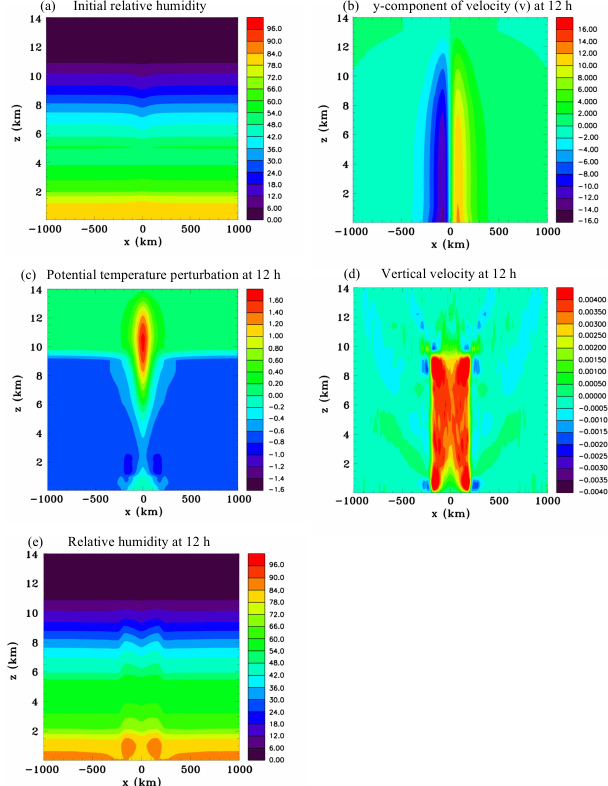
Figure 10. Vertical sections for Experiment 8: the forced core case at t = 1 and 12h. (a) and (b) potential temperature perturbation (K), (c) and (d) vertical velocity (ms − 1 ), and (e) and (f) relative humid- ity, at t = 1 and 12h, respectively.